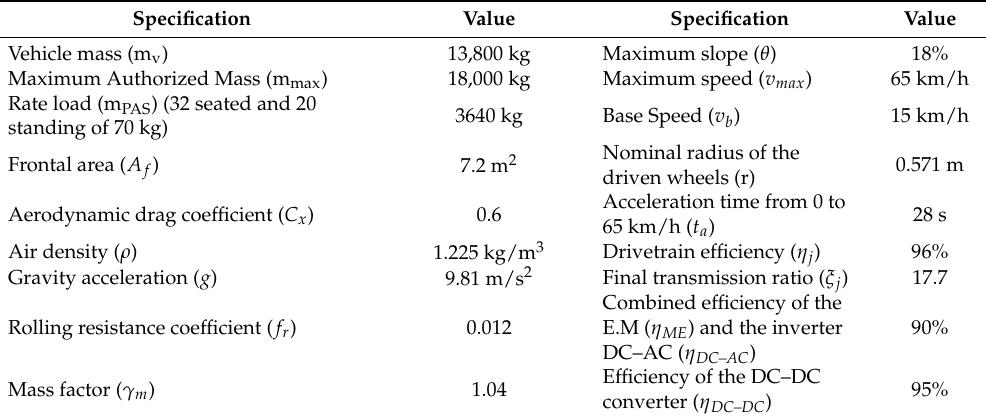
Table 5. Specifications of the electric urban bus.